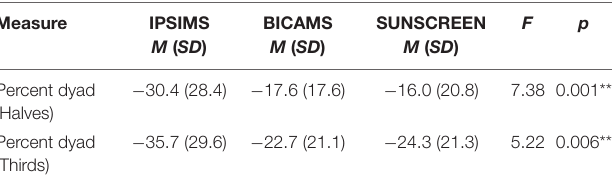
TABLE 3 | Between-study differences in 2 (cid:48)(cid:48) PASAT cognitive fatigability measures for the MS